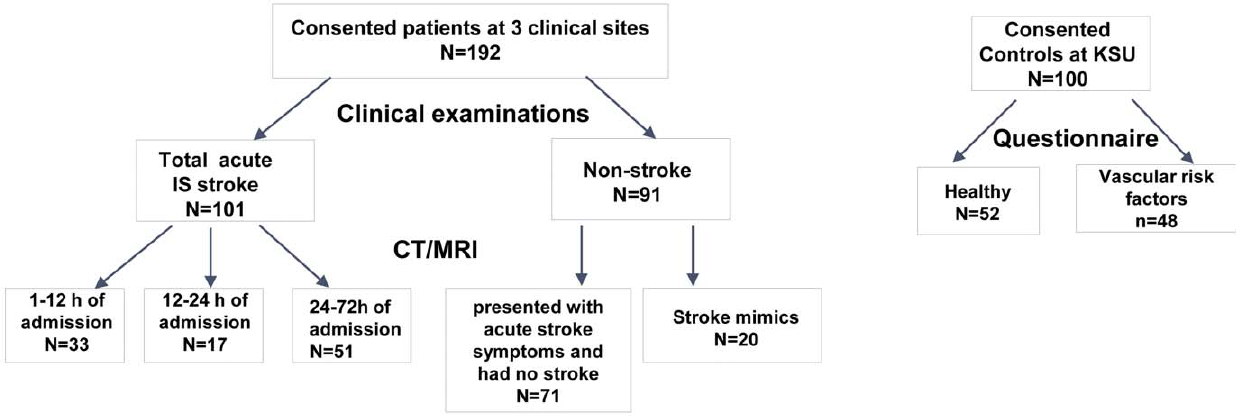
Figure 1. Flow diagram of study population: (i) patients with definite acute ischemic stroke (IS) and TIA, (ii) the non-stroke group included patients presented with acute stroke symptoms and had no stroke and stroke mimics, (iii) control group comprising healthy volunteers and persons with controlled vascular risk factors (hypertension, diabetes mellitus, and heart disease).